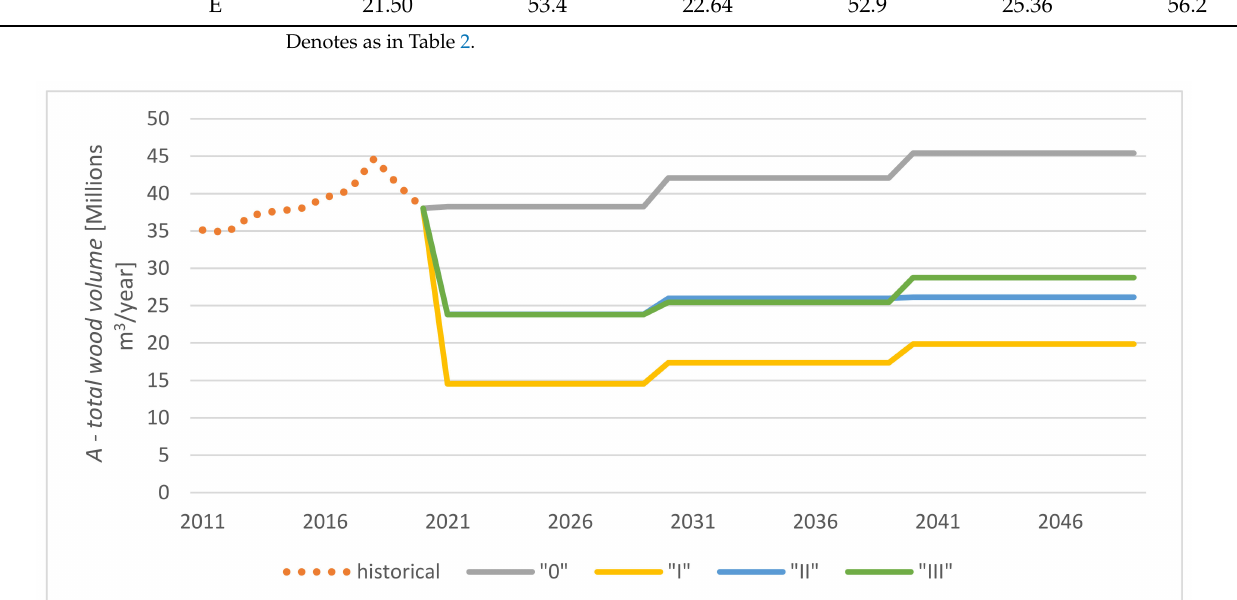
Figure 1. Change in total logging in the scenarios compared with the historical total logging